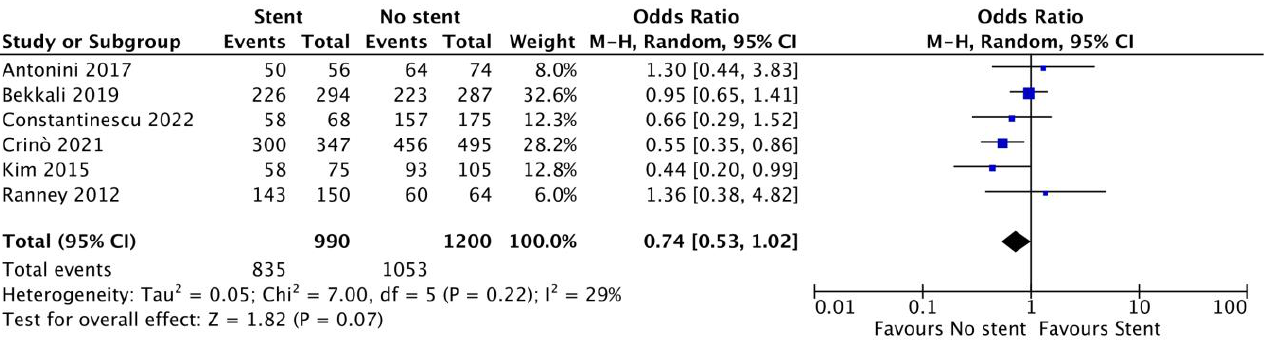
Figure 1. Flow chart of the included studies.